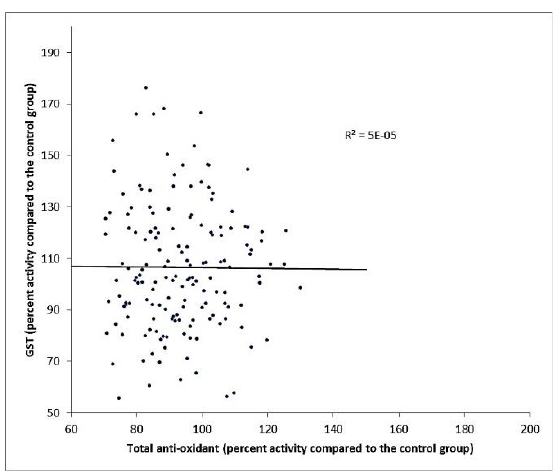
Figure 7. Linear regression between GST activity and total antioxidant activity.